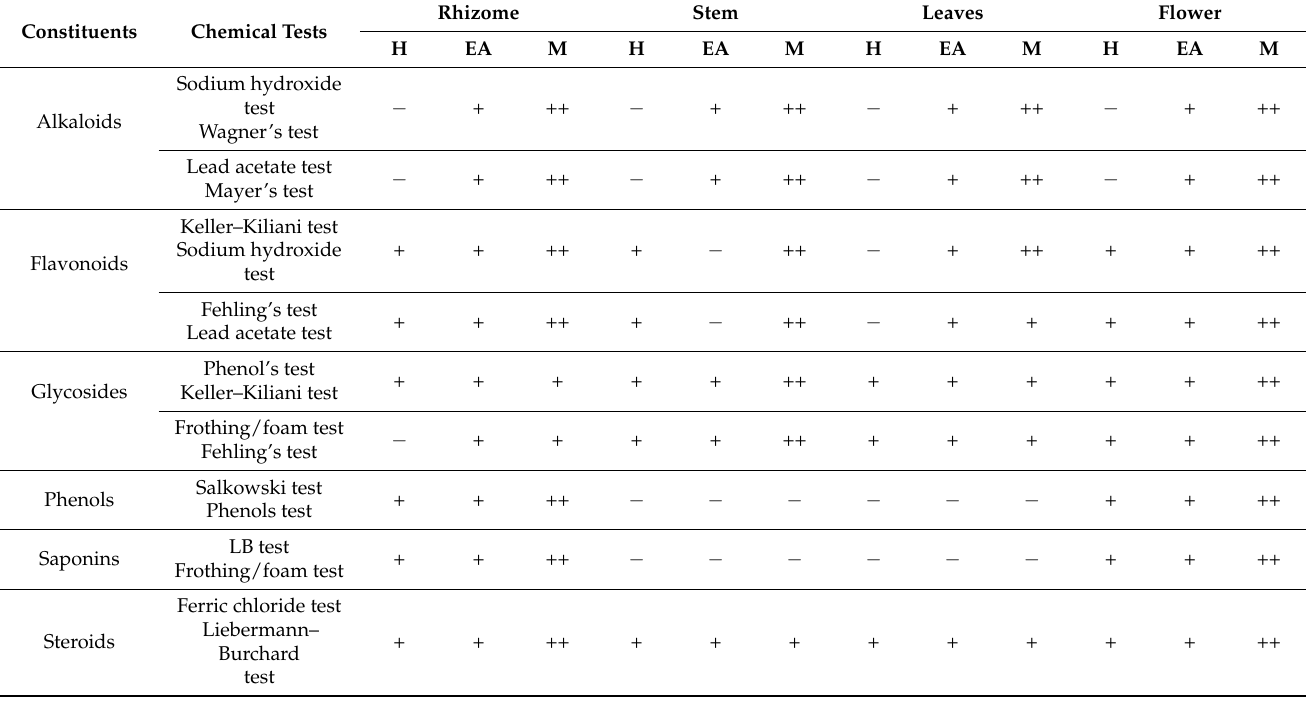
Table 1. Qualitative phytochemical screening of Aconitum chasmanthum